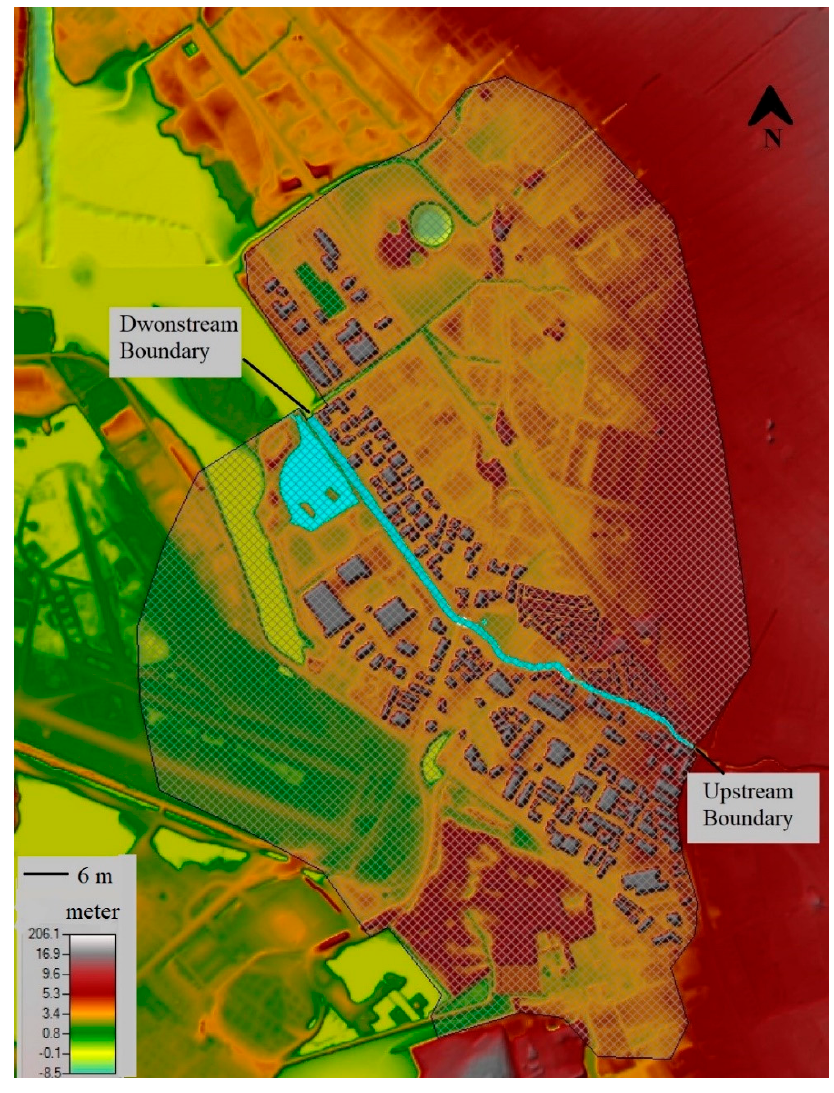
Figure 6. Digital Elevation Model and 2D modeling domain of the study area.